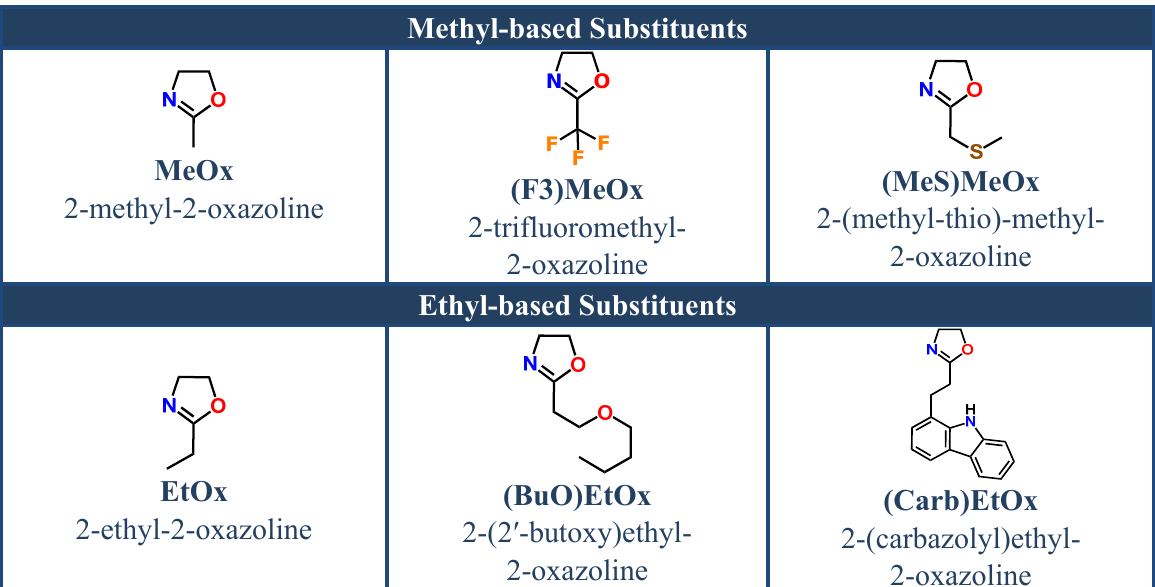
Table 1. Overview of the 2-oxazoline monomers described in this review. Acronyms are defined such that they meet the style (XX)AA = Ox(YY), according to which AA or AA = , respectively, specifies the substituent in 2-position of the 2-oxazoline ring ( = and ≡ are indicative of C–C double and triple bonds of the AA substituent), XX specifies the substitution pattern of the AA substituent, and YY specifies the substitution pattern of the 2-oxazoline ring in its 4- and/or